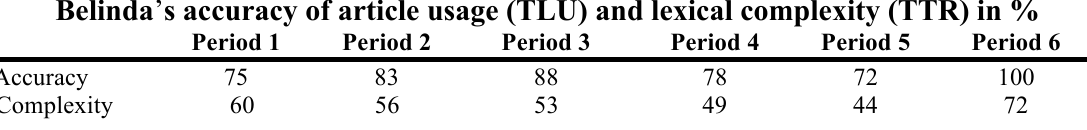
Belinda ’ s accuracy of article usage (TLU) and lexical complexity (TTR) in